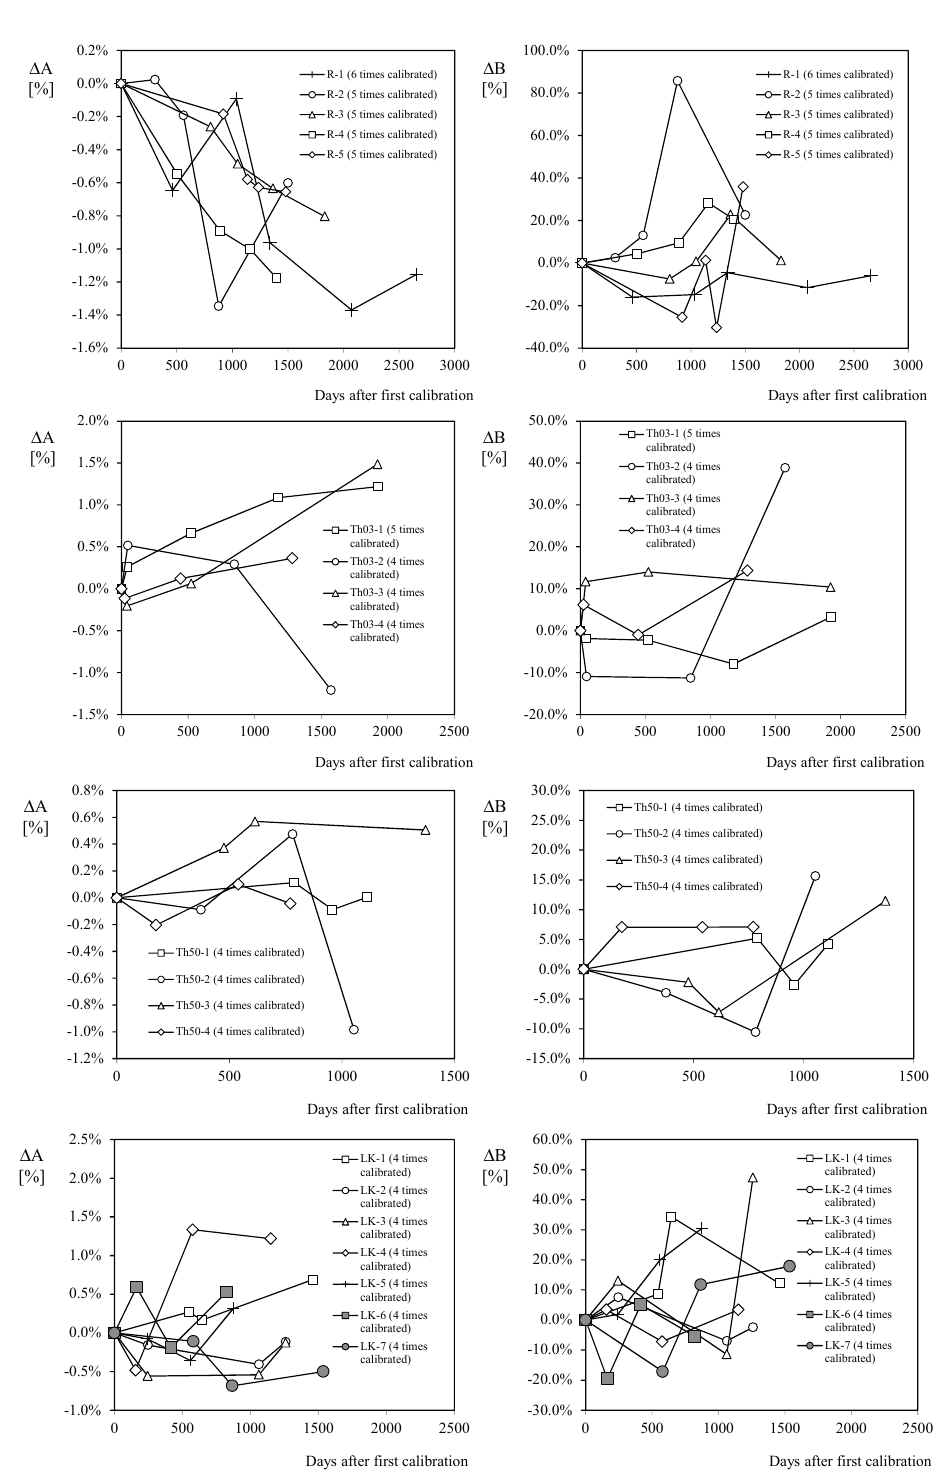
Figure 14. Percentage variation of calibration constants A and B from the initial values with regard to (from top to bottom): Risø P2546 anemometers (R-1 to R-5) calibrated more than four times; Thies Clima 4.3303 anemometers (Th03-1 to Th03-4) calibrated more than three times; Thies Clima 4.3350 anemometers (Th50-1 to Th50-4) calibrated more than three times; and Vector Instruments A100 LK anemometers (LK-1 to LK-7) calibrated more than three times. See in Table 2 the maintenance procedures on these anemometers between